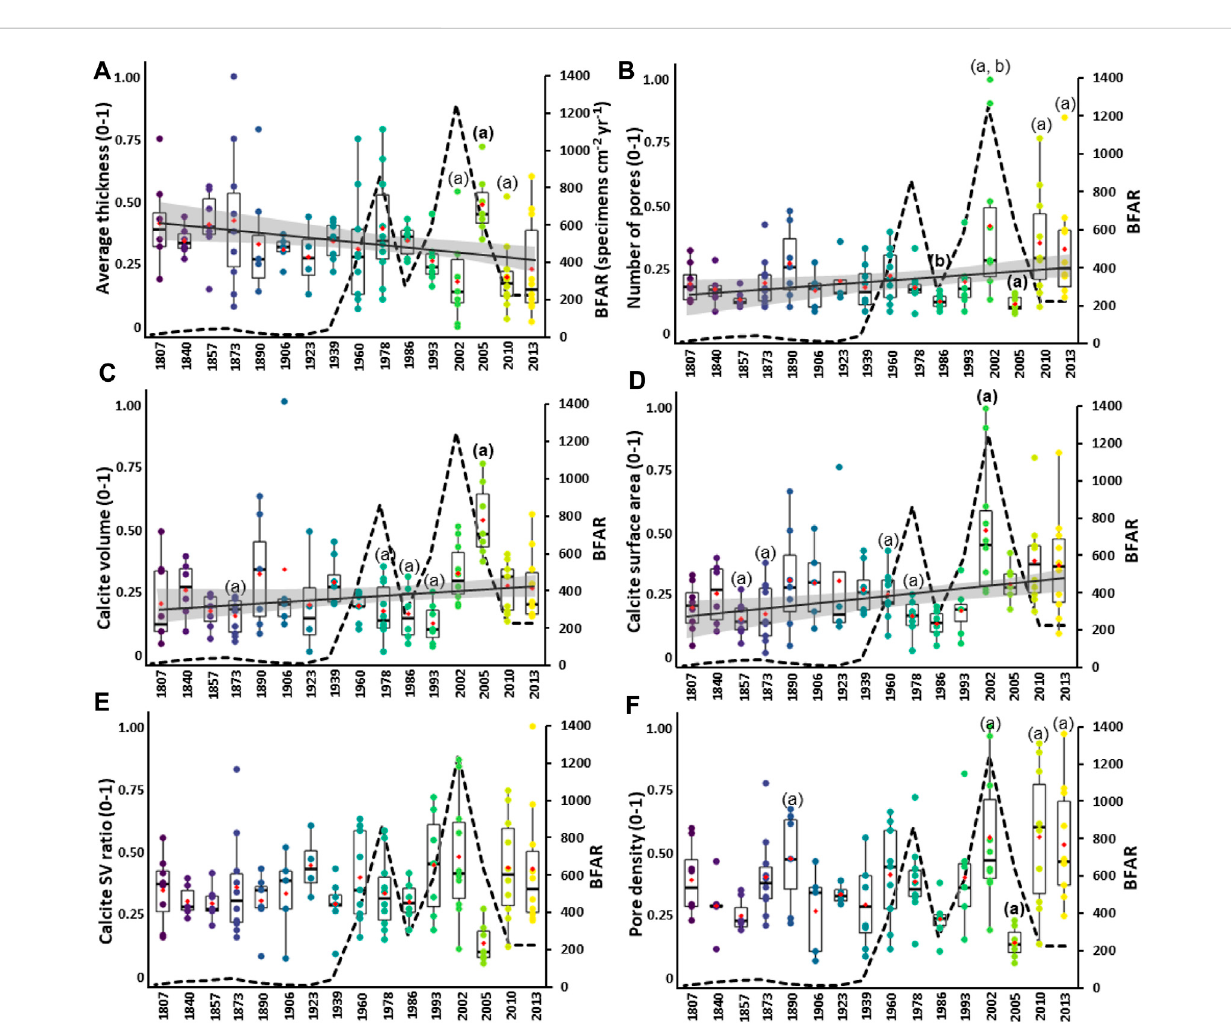
FIGURE 7 3D time series based on the morphological parameters in Elphidium clavatum from the Baltic Sea entrance over the last 200 years. (A) Average thickness. (B) Number of pores. (C) Calcite volume. (D) Calcite surface area. (E) Calcite SV ratio. (F) Pore density. Boxplots are shown with colored individual data points per estimated year, the red diamond indicates the mean. The morphological values (y-scale) are adjusted (0 – 1). The bold letters (A, B) indicate signi fi cant differences according to Dunn post-hoctest. The dotted line is theBFAR of E. clavatum (specimens cm − 2 yr − 1 )from Charrieau et al. (2019). A regression line (black line) with a 95% con fi dence interval (grey area) represents the long-term trend when signi fi cant with the Mann- Kendall